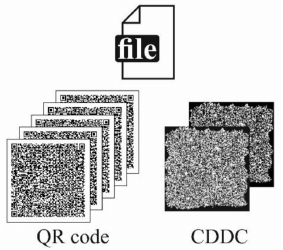
Figure 2. Higher density of data encoding in MCDDC compared to QR code.